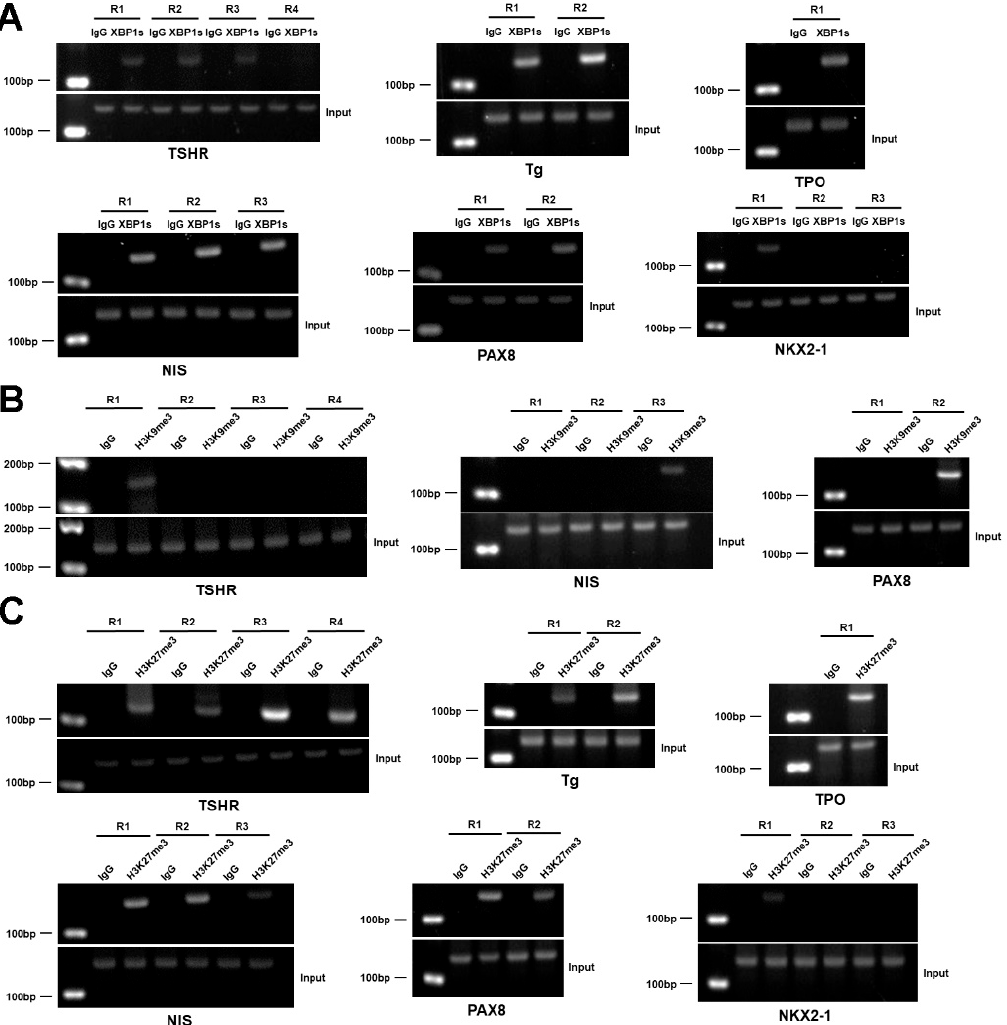
Figure 7. ChIP analysis of XBP1 recruitment and H3K9me3/H3K27me3 levels on the promoters of genes involved in TH synthesis. ( A – C ) ChIP-PCR analysis of the recruitment of XBP1s ( A ) and H3K9me3 ( B ) and H3K27me3 ( C ) on the promoters of TSHR, Tg, TPO, NIS, PAX8, and NKX2-1 in Nthy-ori 3-1 cells after tunicamycin treatment for 6 h.